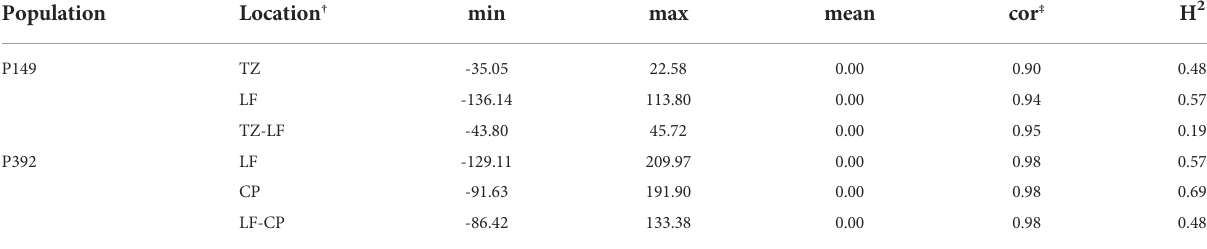
TABLE 2 The result of BLUP in LF and TZ. .